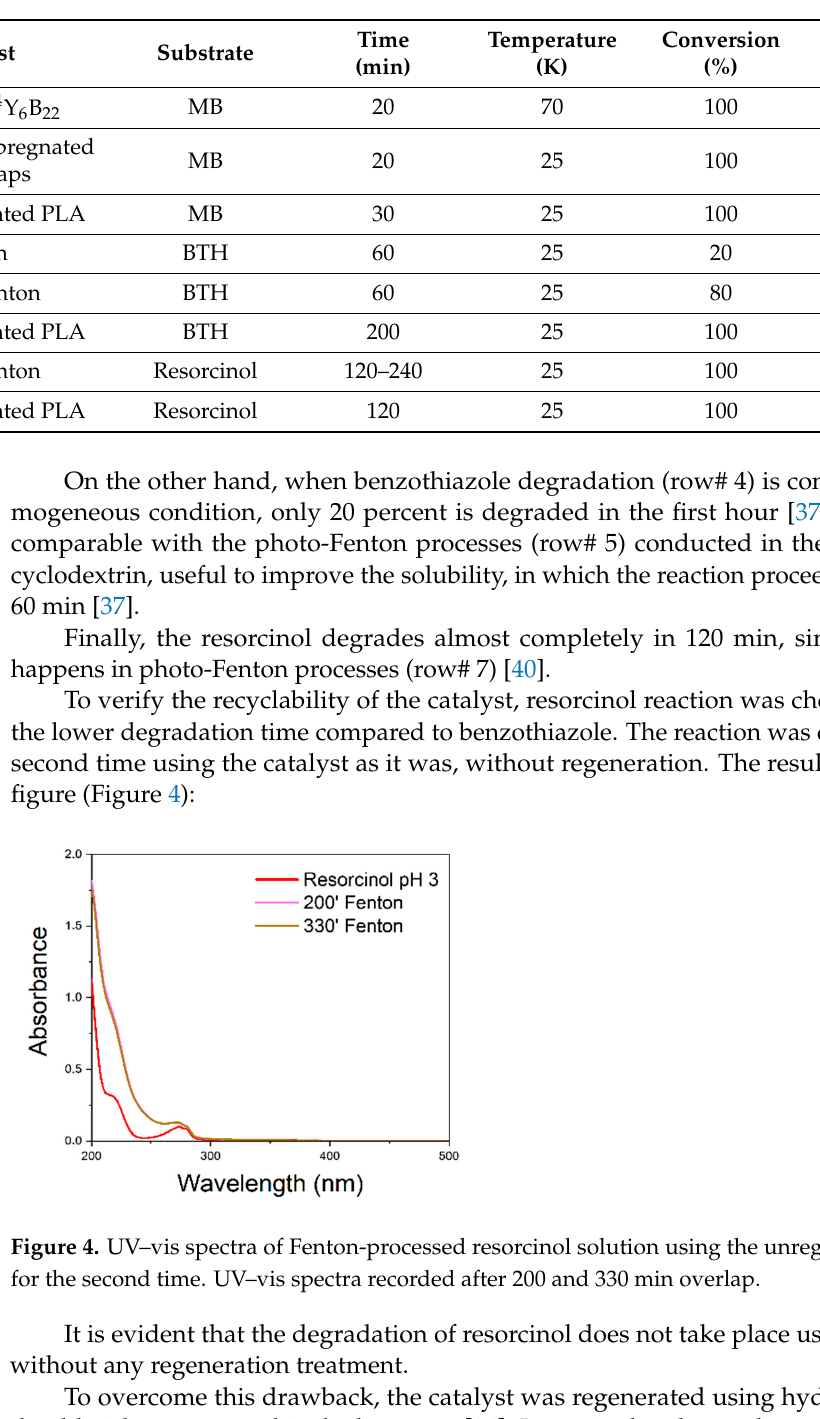
Figure 5. UV–vis spectra of Fenton-processed resorcinol solution using the catalyst after regeneration with hydroxylamine hydrochloride. Figure 5 shows that the resorcinol degradation takes place in three consecutive experiments carried out using the same catalyst after regeneration with hydroxylamine hydrochloride. Therefore, we can conclude that during the Fenton reaction there is no relevant Fe(II/III) leaching affecting the catalytic activity in three consecutive cycles of reactions and regenerations.